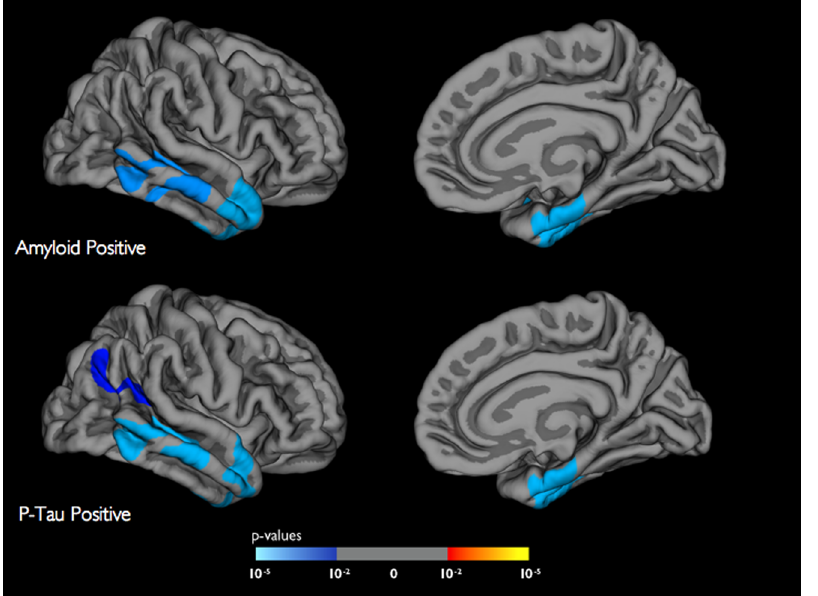
Figure 2. General linear model analyses demonstrating the prediction of longitudinal hippocampal atrophy (over one year) using baseline cortical thickness for the amyloid positive (top panel) and p-tau positive individuals (bottom panel). All results are corrected for multiple comparisons by method of Monte Carlo simulation and shown on the gray matter surface (only right hemisphere). The color scale illustrates the magnitude of effect with blue indicating areas of strongest prediction strength.